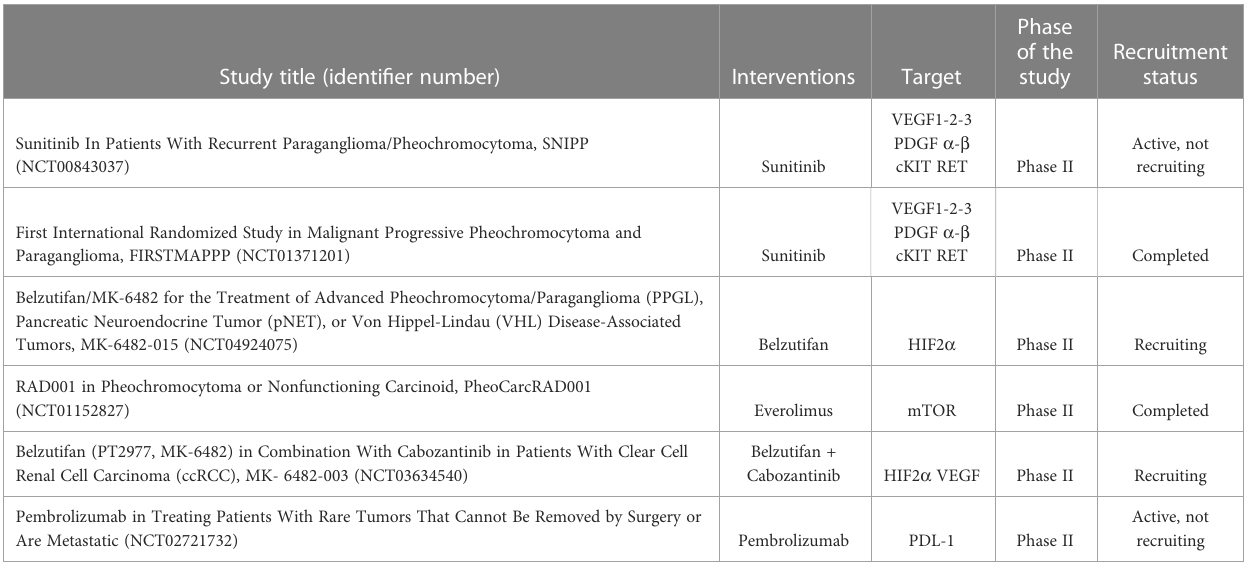
TABLE 2 Summary of the ongoing Clinical Trials acting on different intracellular signalling